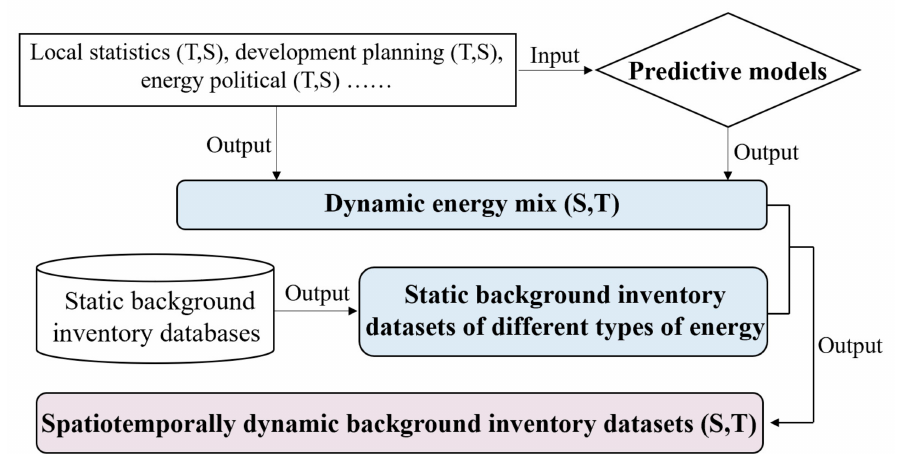
Figure 2. Dynamic quantification flowchart of the background inventory of